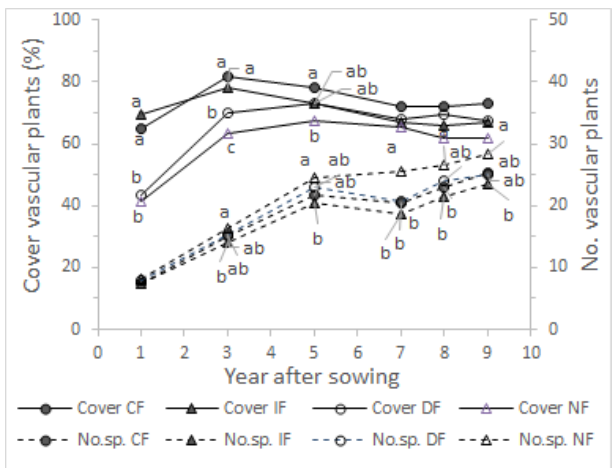
Figure 2. Time pattern of plant cover and species number at a ski slope grassland restoration ex- periment in four fertilisation treatments (values are averages of four propagation materials from a Nardo-Agrostion donor grassland). Letters show results of among-fertilisation comparisons within each year. Means with common letters do not differ at p ≤ 0.05. Missing letters mean that fertilisation effect was not significant. CF, IF, DF, and NF mean continuous, initial, delayed and no fertilisation, respectively.